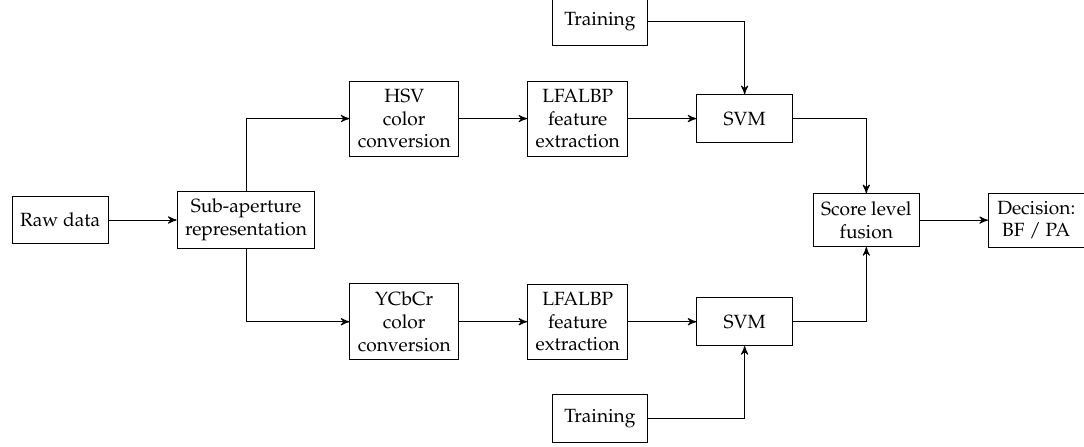
Figure 16. Schematic representation of the workflow for computing the LBP HVS + YC